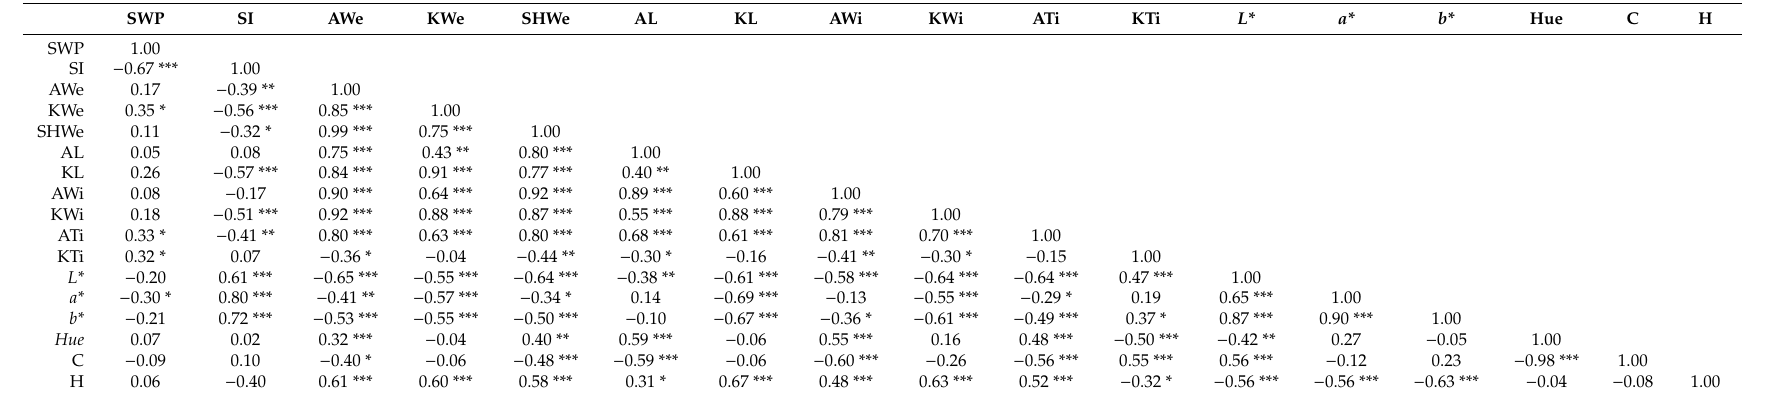
Table 1. Pearson’s correlation coe ffi cients (R) among stem water potential and stress integral with morphological